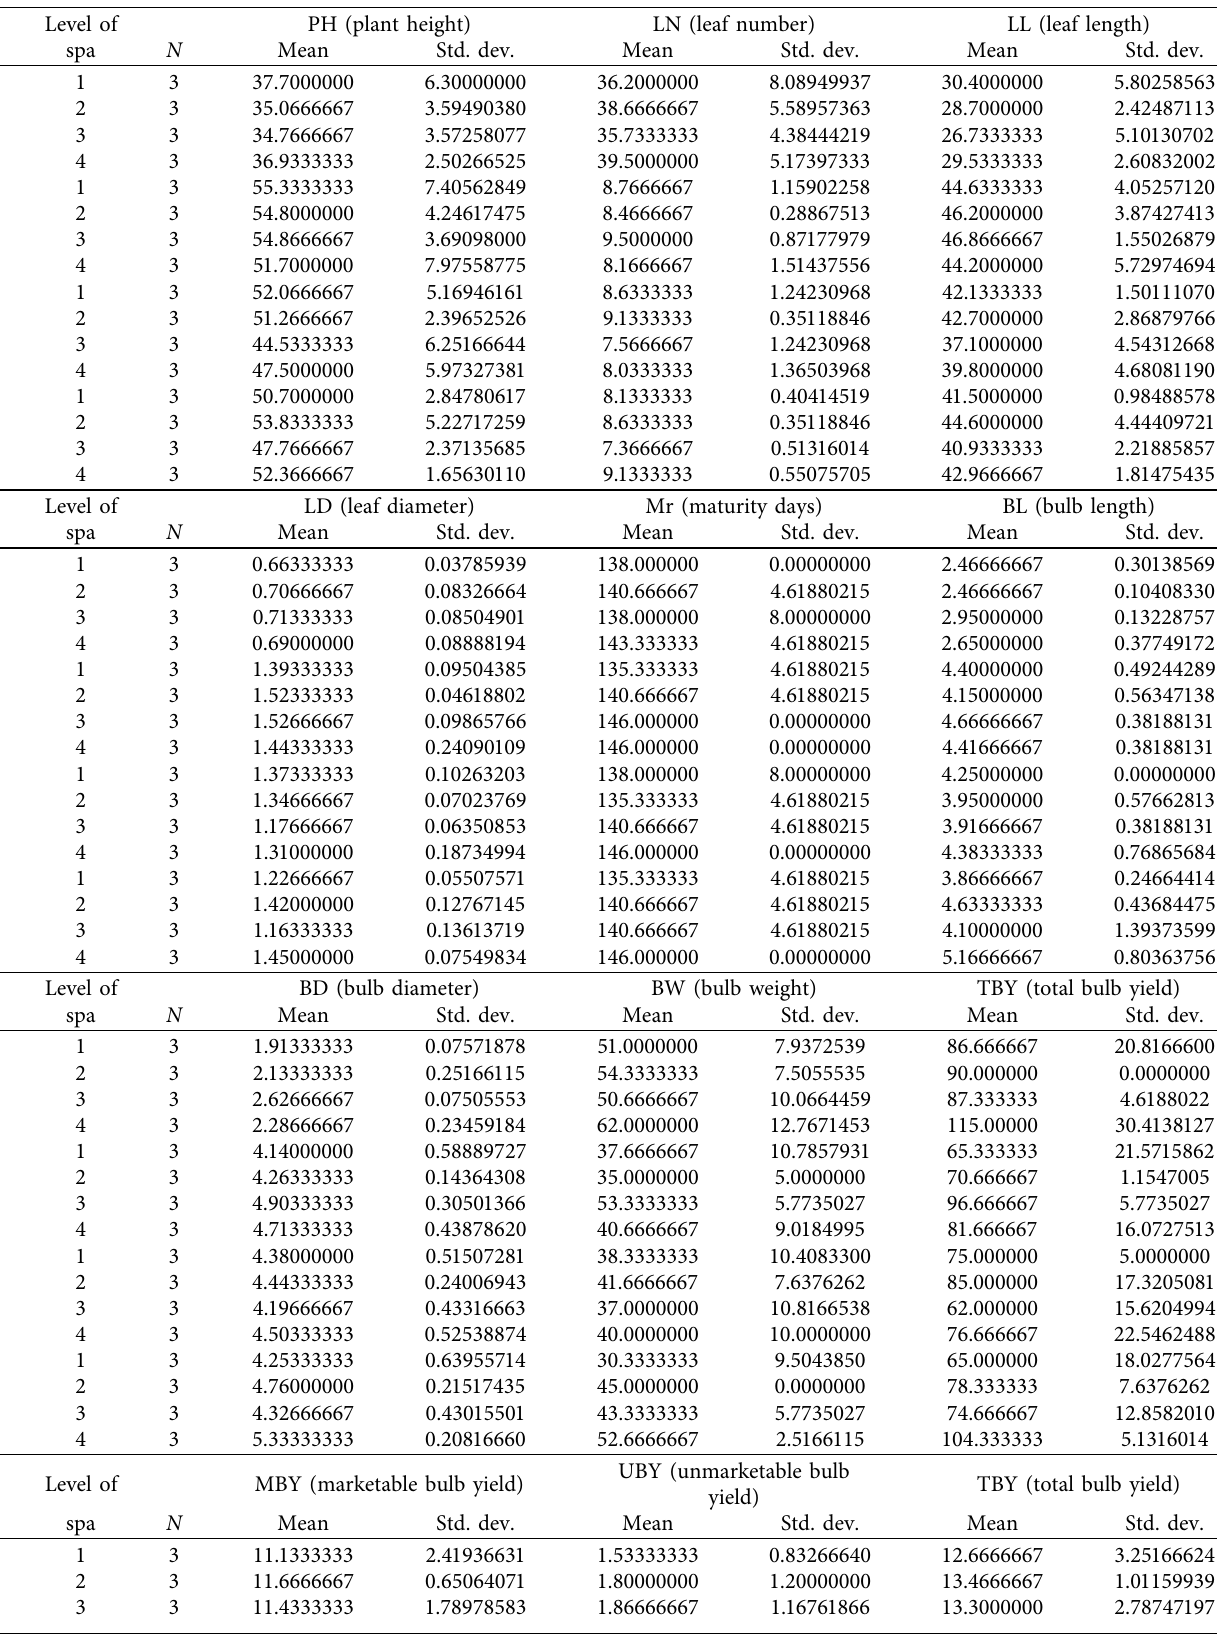
Table 2: Mean and standard deviation of vegetative and yield